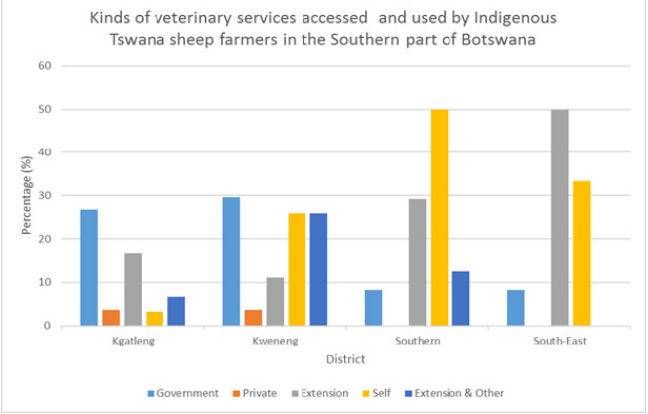
Figure 3. Veterinary services accessed and used by Indigenous Tswana sheep farmers in the four districts of Botswana. districts of